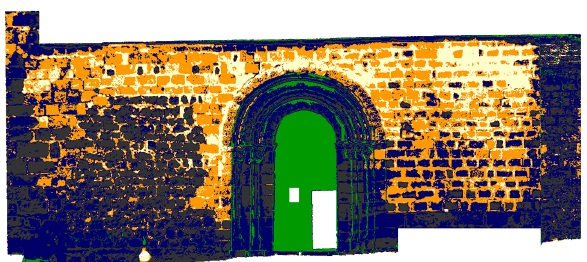
Figure 6. Mini MCA6 map for the 6-classes unsupervised classification.